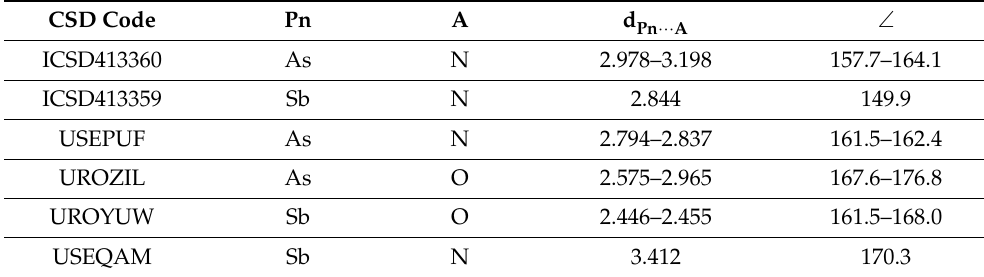
Figure 9. Ball-and-stick representation of the solid state of USEQAM structure showing the 1D infinite assembly. The PnBs are represented using dashed lines. H atoms omitted for clarity. Table 4. CSD codes, PnB donor (Pn) and acceptor (A) atoms, intermolecular distance (d Pn ··· A in Å), and X–Pn ··· A (X = N and O) angle ( ∠ in ◦ ).